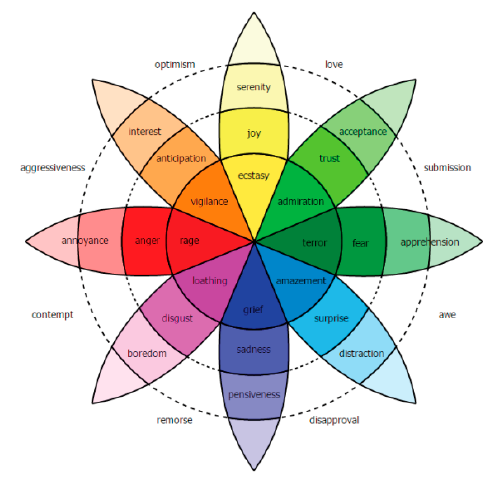
Figure 1. Plutchik emotion wheel.